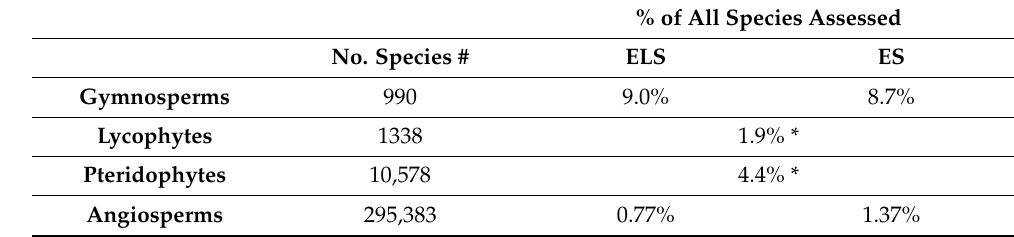
Table 1. The proportions of species assessed in the two databases.